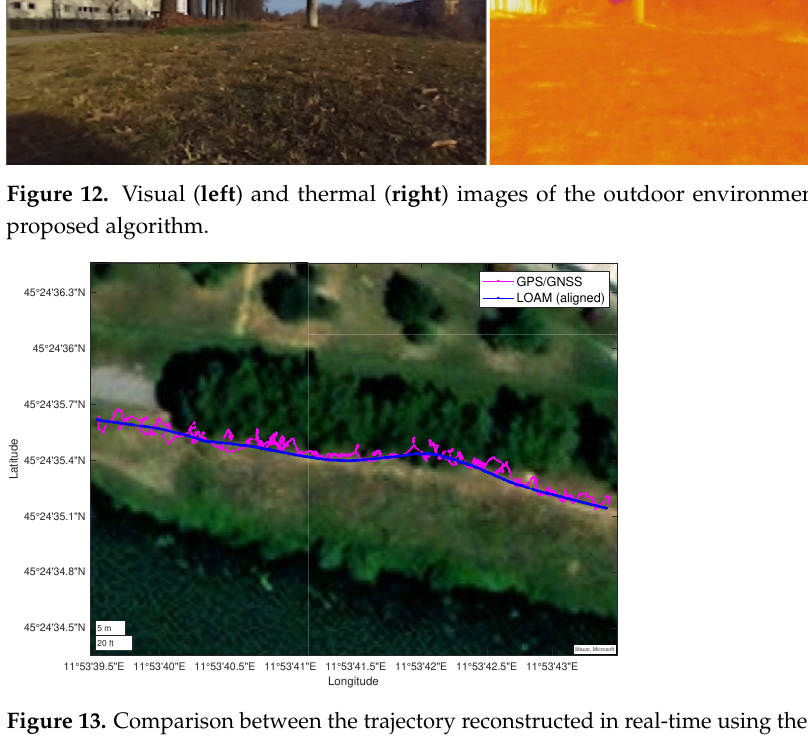
Figure 13. Comparison between the trajectory reconstructed in real-time using the livox_horizon_loam algorithm (blue) and the path traced by the rover’s GPS/GNSS receiver (purple). Here the Horn’s quaternion-based algorithm was used to align the two paths and to represent the reconstructed trajectory in the same latitude/longitude/altitude coordinate system used for the GPS/GNSS